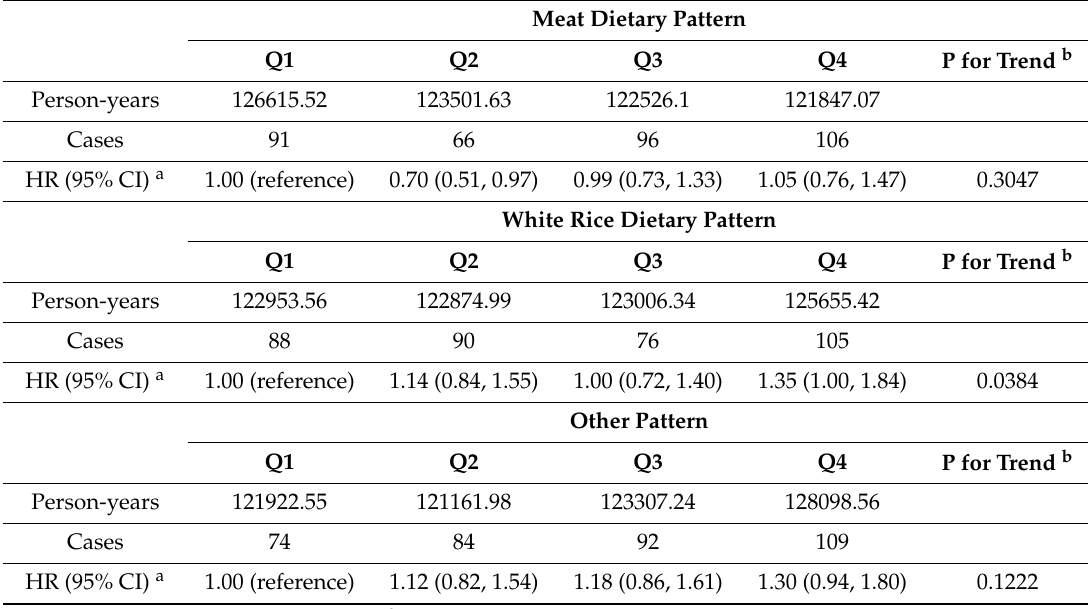
Table 4. Hazard Ratios (HR) and 95% Confidence Intervals (CI) of Breast Cancer according to of Each Dietary Pattern Score.